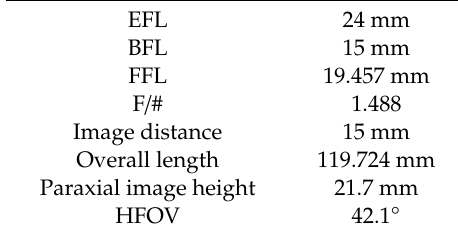
Figure 7. Optical path diagram of basic design data. Table 4. First orders of basic